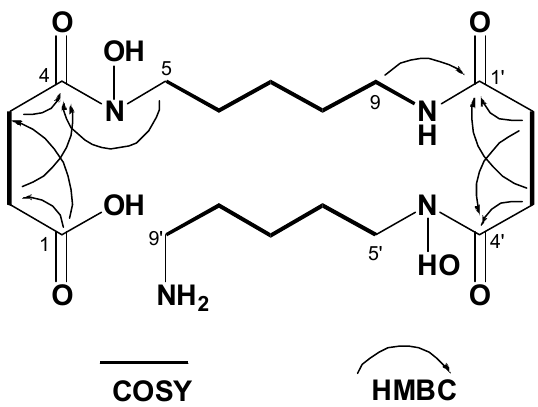
Figure 3. COSY and key HMBC correlations for bisucaberin B ( 1